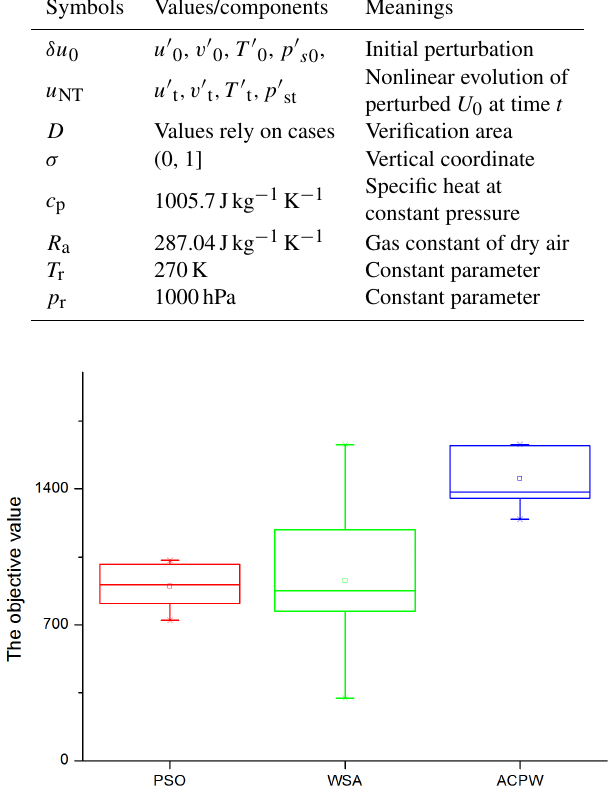
Figure 2. Box plot of the PSO, WSA and ACPW methods for TC Fitow at the 60km resolution. The red box denotes PSO, the green box is for the WSA, and the blue box shows the results of the ACPW algorithm.